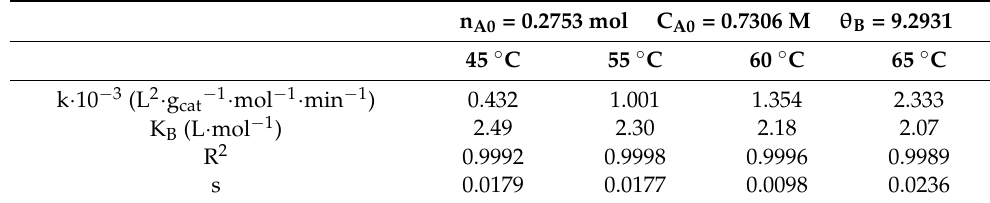
Table 7. Kinetic parameters by using the ER model at different reaction temperatures. Experimental conditions: catalyst addition, 5% w / w ; methanol/oil ratio, 9:1; stirring rate: 700